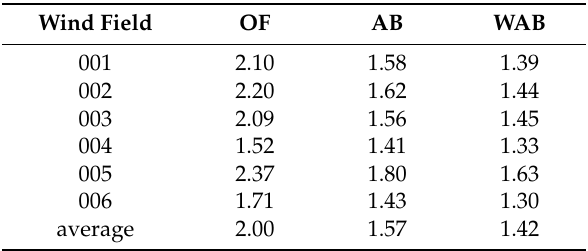
Table 6. Continuous ranked probability skill ( CRPS ) of original (OF), AB and WAB corrected ensemble forecasts.